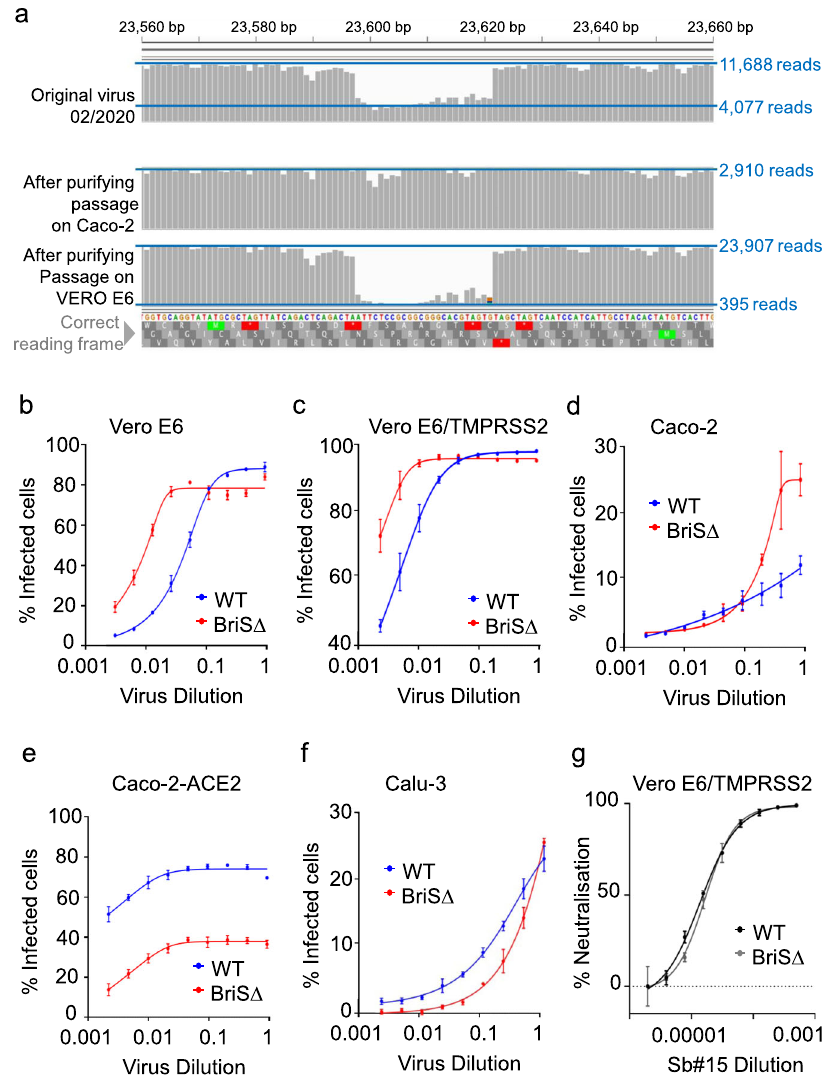
Fig. 1 hCoV-19/England/02/2020 derived SARS-CoV-2 BriS Δ variant. a Depth of read across S glycoprotein gene at furin cleavage site is shown for three different stocks of SARS-CoV-2 isolate hCoV-19/England/02/2020. Horizontal blue lines indicate read depth. The original stock of virus (top) evidences sharp decline in read depth corresponding to in-frame deletion of the furin cleavage site and indicative of a mixed population of viruses. The middle panel shows the sequencing depth at same region for a virus stock that has been isolated by growth on human Caco-2 cells and puri fi ed by limiting dilution. The bottom panel shows the equivalent sequencing data for a stock of the SARS-CoV-2 BriS Δ variant grown on Vero E6 cells and puri fi ed by limiting dilution. b – f SARS-CoV-2 infection assays: Approximately equal amounts of the WT virus and BriS Δ virus based on genome amounts (estimated by qRT-PCR) were diluted (2-fold dilution series starting with neat virus) and used to infect Vero E6, Vero E6/TMPRSS2, Caco-2, Caco-2-ACE2, and Calu- 3 cells. At 18 h after infection, cells were fi xed, stained with an anti-N antibody and the % of cells infected was determined by immuno fl uorescence microscopy. Data ( b – f ) are presented as mean values ±SD. n = 3 biological replicates. g WT virus and BriS Δ virus were used to infect Vero E6/TMPRSS2 cells in the presence of a range of dilutions of a commercial antibody against SARS-CoV-2 RBD. Cells were infected with equal amounts of infectious virus (based on cell infectivity). At 18 h after infection, cells were fi xed and stained with an anti-N antibody and the % of cells infected was determined by immuno fl uorescence microscopy. Data are presented as mean values ±SD. n = 2 biological replicates. Source data for graphs shown in panels b – g are provided as a Source Data fi